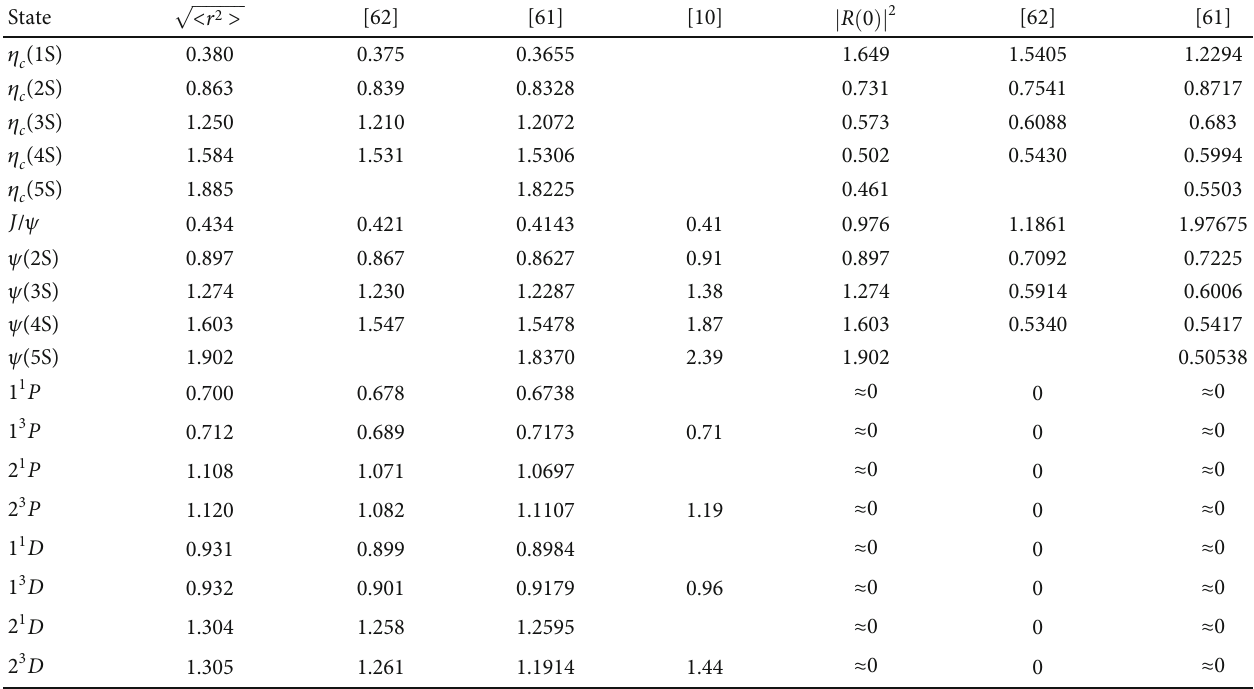
Table 3: Average radii (in fm) and square of the radial wave function at the origin (in GeV 3 ).